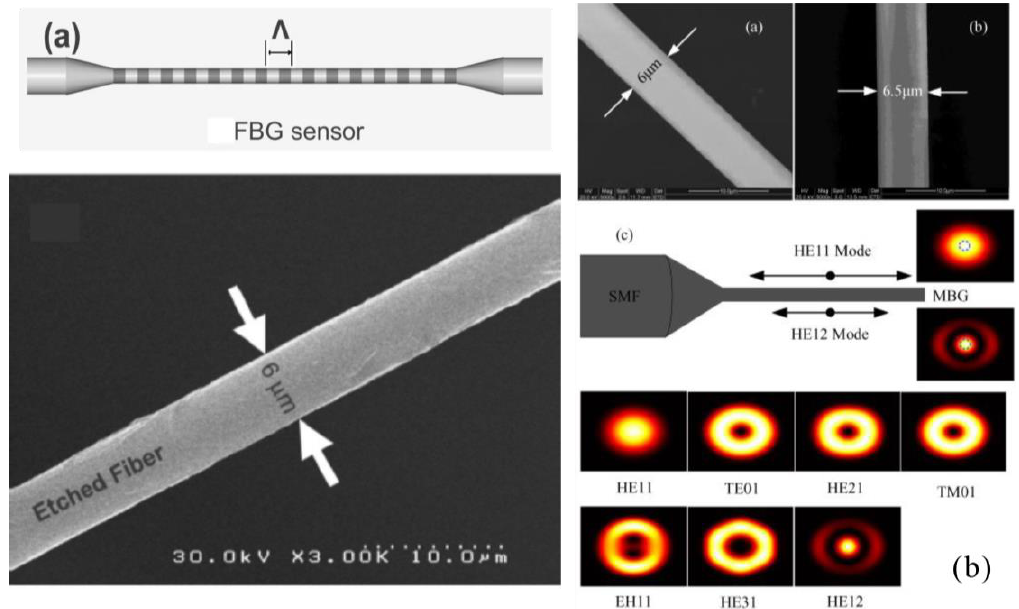
Figure 16. ( a ) Schematic and SEM image of microfiber-based fiber Bragg grating (FBG) [228]; ( b ) SEM images of microfiber-based FBGs and the schematic diagram of the operation principle of mode coupling in the microfiber-based FBG [229].